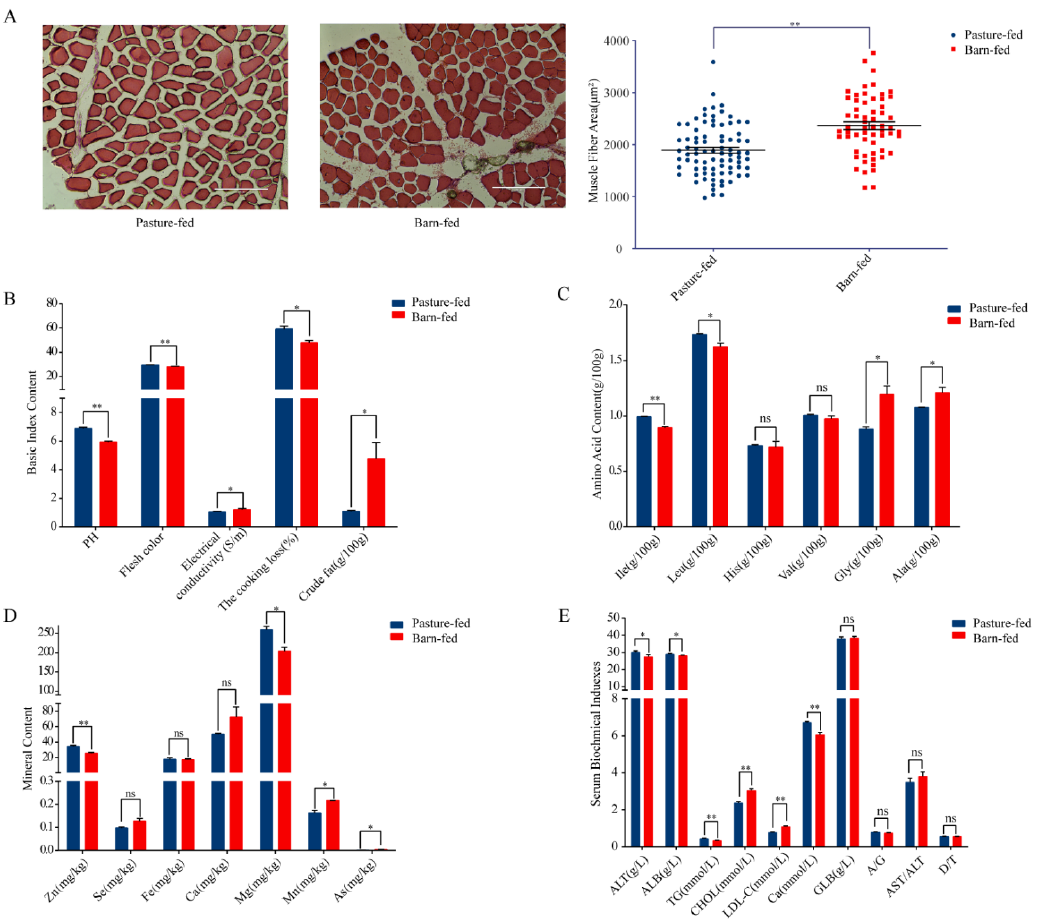
Figure 1. Physiological and biochemical characters in longissimus lumborum from pasture-fed and barn-fed goats. ( A ) Histological frozen section to analysis cross-sectional area of longissimus lumborum. ( B ) Basic nutrition index content of muscle from pasture-fed and barn-fed goat meat. ( C ) The amino acids content with significant differences between pasture-fed and barn-fed goat meat. ( D ) Mineral content in the pasture-fed and barn-fed goat meat; ( E ) Serum biochemical indexes of the pasture-fed and barn-fed goat meat. ALT: glutamic-pyruvic transaminase; ALB: serum albumin; GLB: seroglobulin; D/T: direct bilirubin/Total bilirubin. * and ** indicate significant different ( p < 0.05 or p <